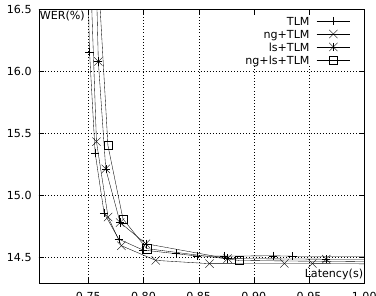
Figure 2. WER versus mean empirical latency (in seconds) on dev1-dev , measured with different pruning parameters for the search, and considering only interpolation schemes including TLM.